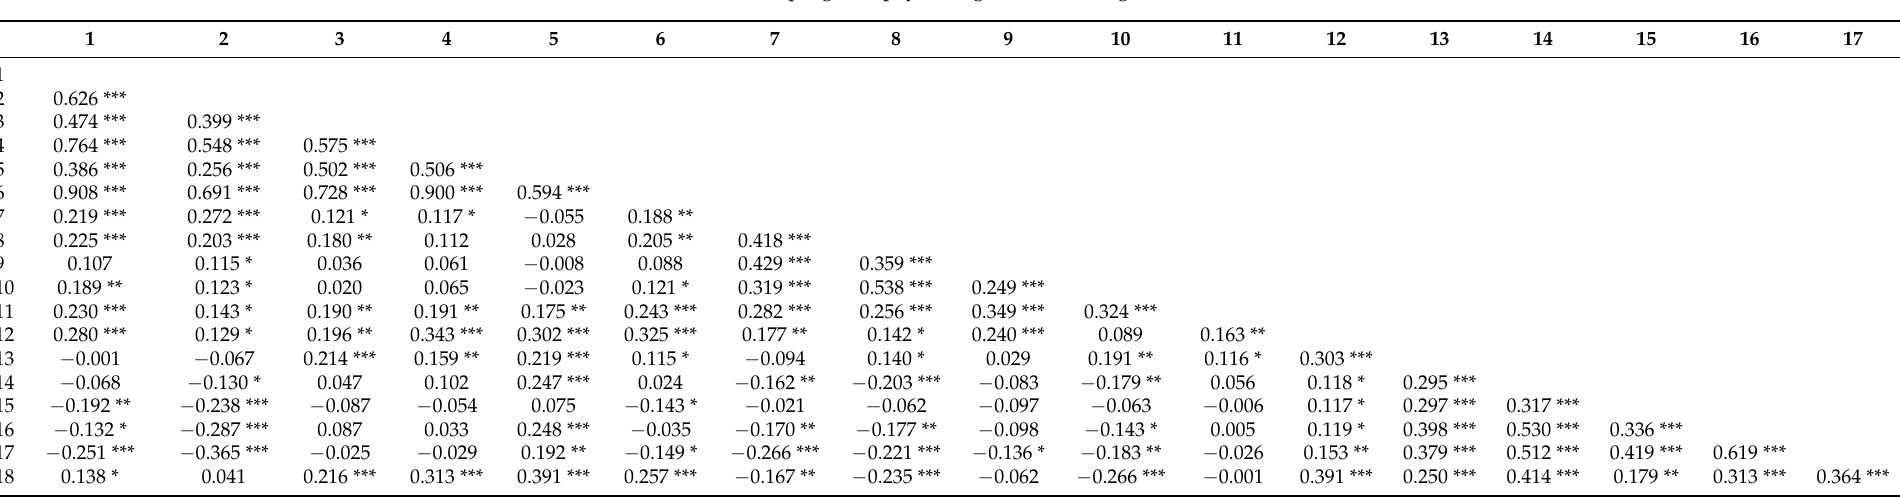
Table 2. Correlation matrix between stressors, coping and psychological